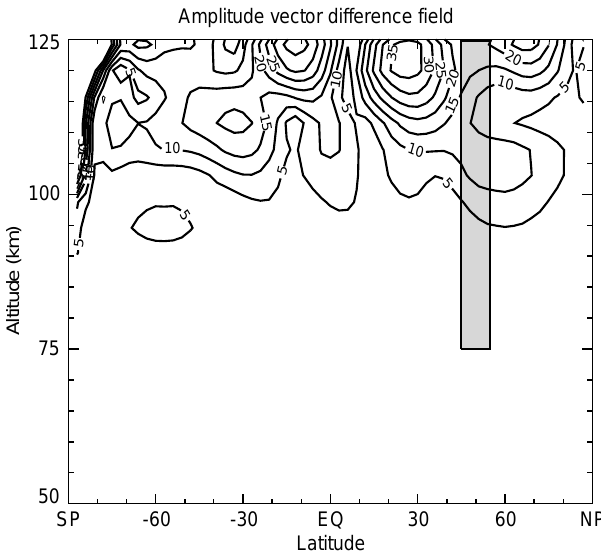
Fig. 11. Amplitude of the vector di(cid:128)erence in simulated meridional semidiurnal tide from the GSWM using the base-case eddy di(cid:128)usivity profile and a modified eddy di(cid:128)usivity profile with a maximum value of 200 m 2 s (cid:255) 1 (see text for details). The amplitude contours are in m s (cid:255) 1 and a positive value indicates the base-case amplitude is larger, while a negative value indicates the base-case amplitude is smaller than the case with the modified eddy di(cid:128)usivity profile. The shaded region indicates the geographic region shown in Fig. 7